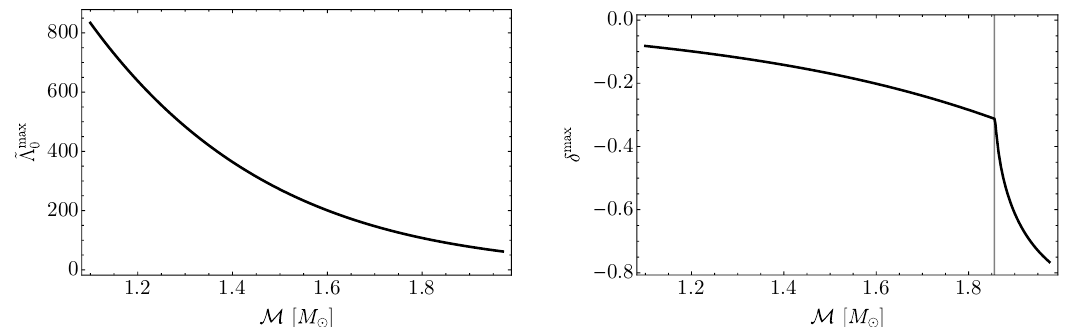
Figure 8. Dependence on the chirp mass in the Hebeler et al. parametrization, keeping the heaviest star mass (cid:12)xed at M 1 = 2 : 27 M (cid:12) (the maximum value for the (cid:3) = (150 MeV) 4 curve). The left plot shows the corresponding value of the combined tidal deformability for the (cid:3) = 0 curve. The right plot represents the relative deviation of the combined tidal deformability by turning on (cid:3) = (150 MeV) 4 and is a measure of how the e(cid:11)ect of VE potentially increases with the chirp mass.